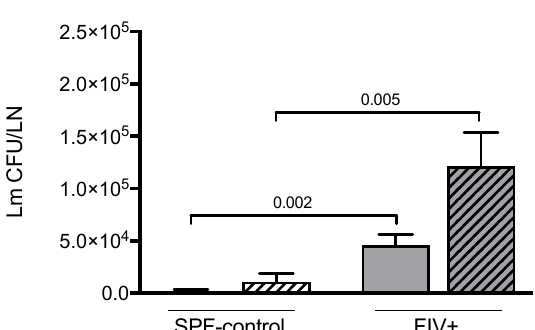
Figure 6. The effect of Treg depletion on Lm clearance. The number of Lm colony-forming units (Lm CFU/LN) were determined 3 days after Lm challenge of SPF-control and chronically FIV-infected (FIV+) cats. Isotype control mAb treated cats (open bars) and anti-CD25 mAb treated cats (hatched bars) are shown. Statistical analysis was performed using Mann–Whitney U test; n = 6 for each treatment group; p -values are shown above brackets that indicate group comparisons.